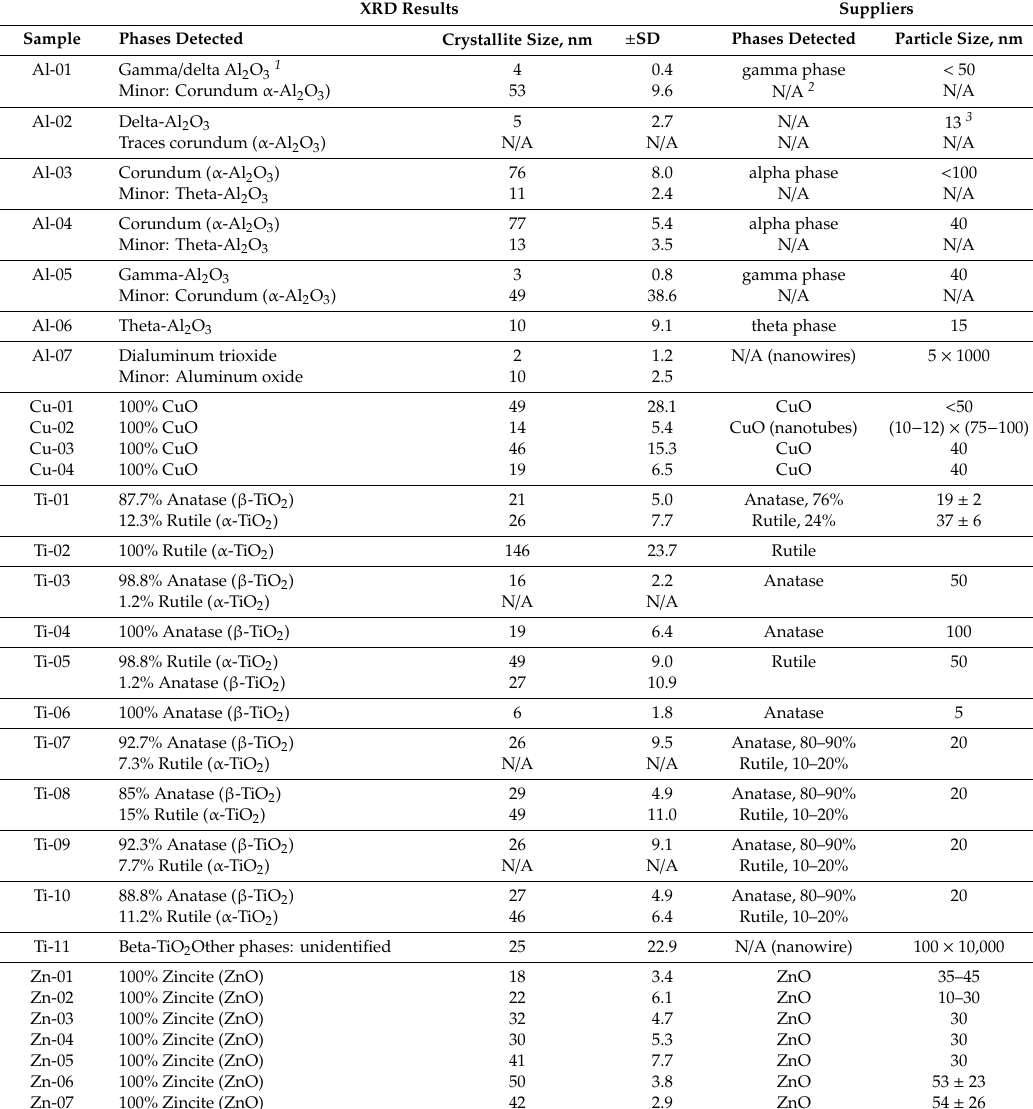
Table 2. Comparison of the XRD results with the phases and particle size provided by the suppliers for the various metal